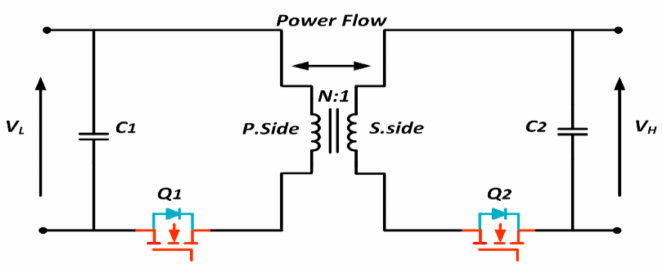
Figure 15. Isolated bidirectional flyback [72].